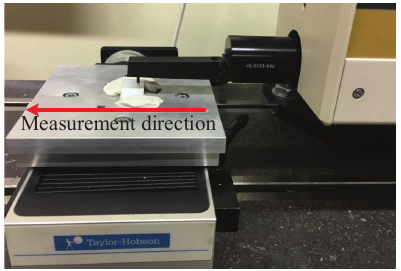
Figure 10. Measurement method adopted after the UVAG experiments.